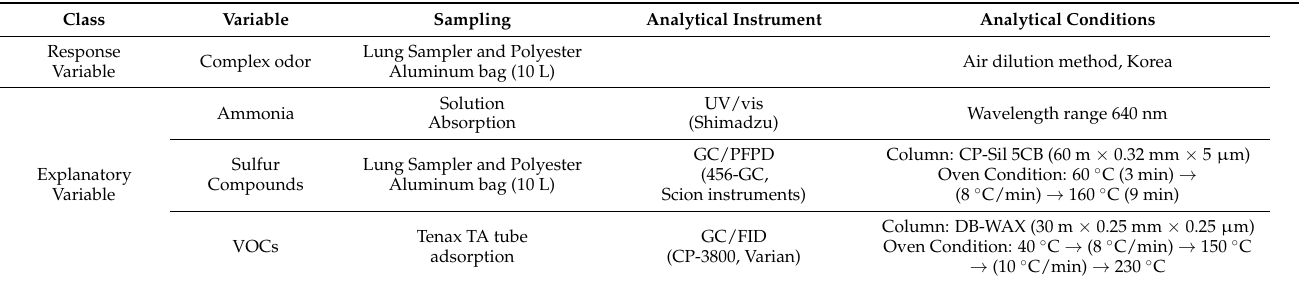
Table 1. Summary of various analytical